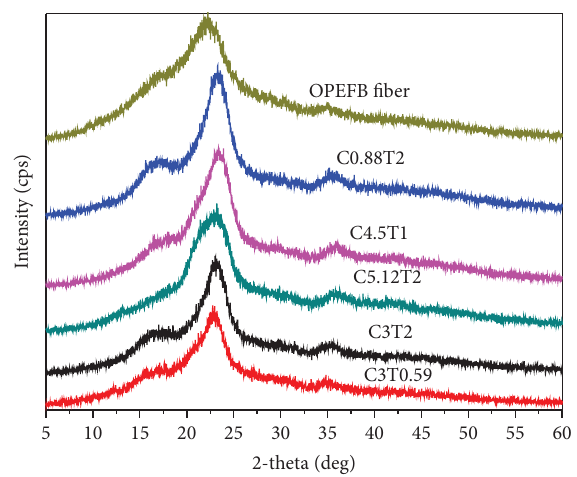
Figure 6: XRD analysis on cellulose with various concentrations of NaClO 2 and bleaching time (C concentration of NaClO 2 (%); T � bleaching time